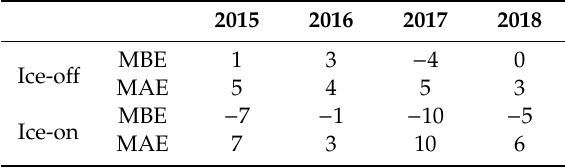
Table 2. Mean bias and mean absolute errors for the pixel-by-pixel extraction of lake ice phenology events (ice-o ff and ice-on) using the first di ff erence